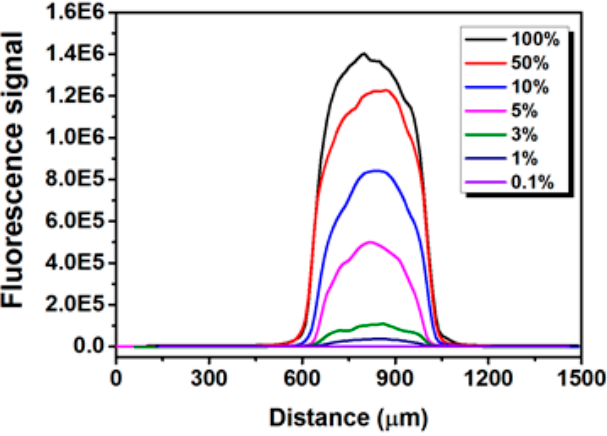
Figure 9. Line profile graph of the fluorescence images shown in Figure 8.